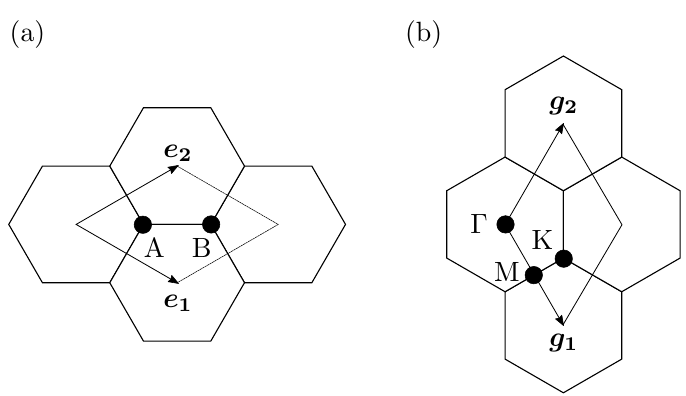
Figure 13: (a) Choice of unit cell for the honeycomb lattice. (b) Reciprocal lattice and Brillouin Zone corresponding to that